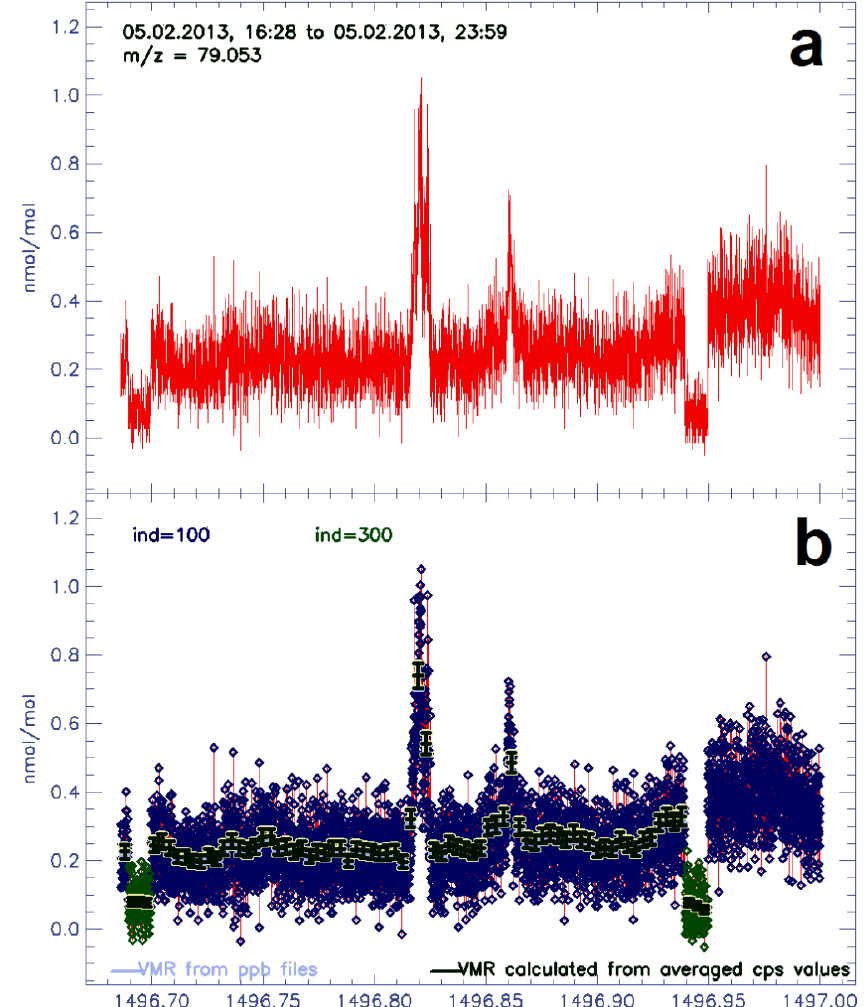
Figure 6. A 7h timeline of m/z = 79 . 053 (benzene) collected at the CESAR observatory (http://www.cesar-observatory.nl/) during the ACTRIS winter campaign in Jan/Feb 2013. The time axis displays days since 1 January 2009; the displayed period (in ordinary date format) is labeled on the top. The upper chart (a) displays the raw data. In the lower chart, markers of different colors correspond to index values as defined in the “New Index File” widget window (Fig. B2b). The black lines correspond to the 300s means and the error bars indicate the standard error due to counting